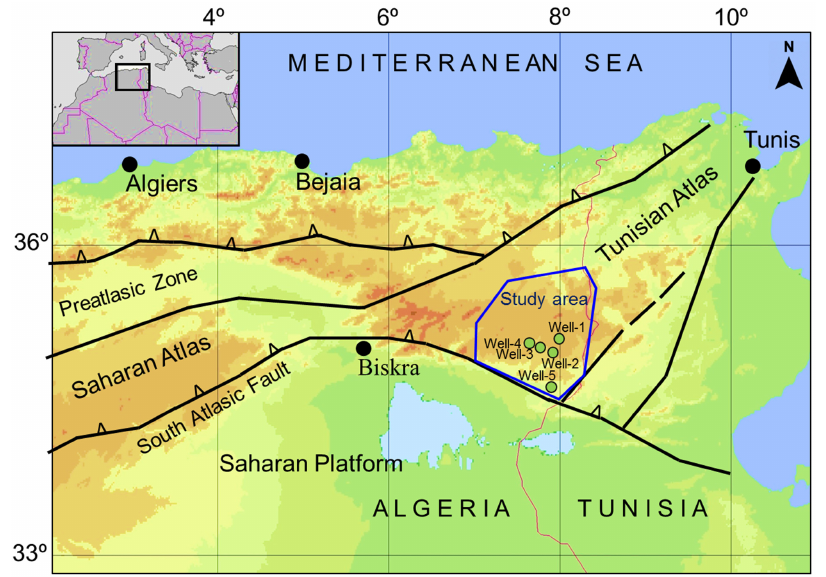
Figure 1. Location map of the southeast Constantine Basin (brown polygon) in northern Algeria. The studied well locations are marked by red circles. Black lines indicate regional structural trends (refer to Baouche et al. [9] for structural trends). Energies 2022 , 15 , 7901